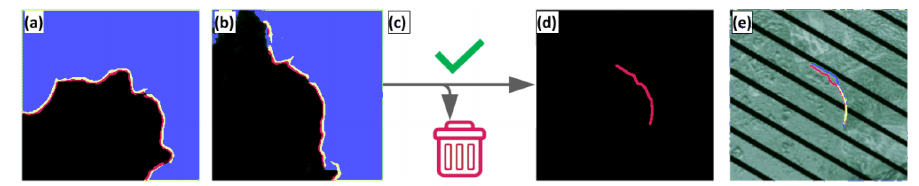
Figure 6. Postprocessing pipeline. (a) First, get the processed image from CALFIN-NN. (b) Then, isolate and re-process each front. (c) Next, filter unconfident predictions. (d) Now, fit line and mask static coastline (see also Fig. 7). (e) Lastly, export and validate the shapefile.